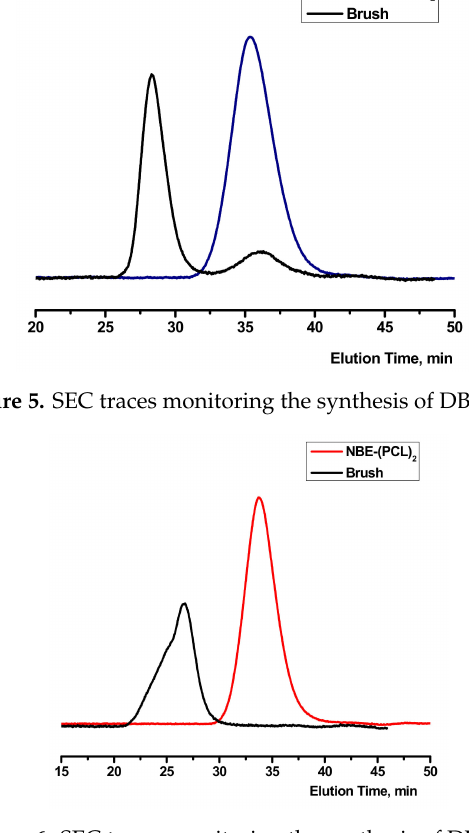
Figure 6. SEC traces monitoring the synthesis of DB-PCL.